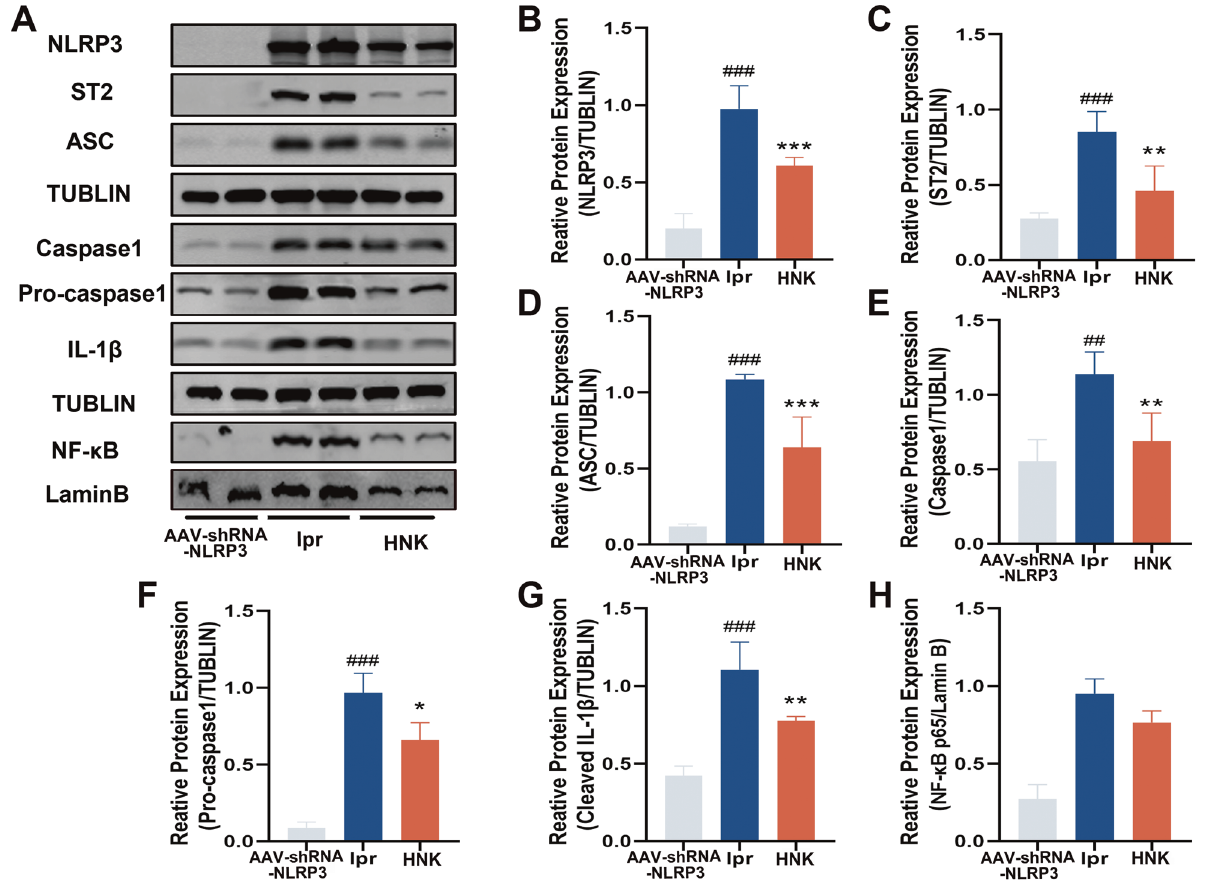
Fig. 5 Effects of Honokiol (HNK) on the renal levels of the NLRP3 in fl ammasome and the ST2 and NF- κ B proteins in MpJ/lpr mice. A Renal levels of the NLRP3 in fl ammasome, ST2, and NF- κ B. B – H Gray-scale analysis ( n = 3, */# p < 0.05, **/## p < 0.01; # the lrp group versus the AAV- shRNA-NLRP3 group; * the HNK group versus the lpr